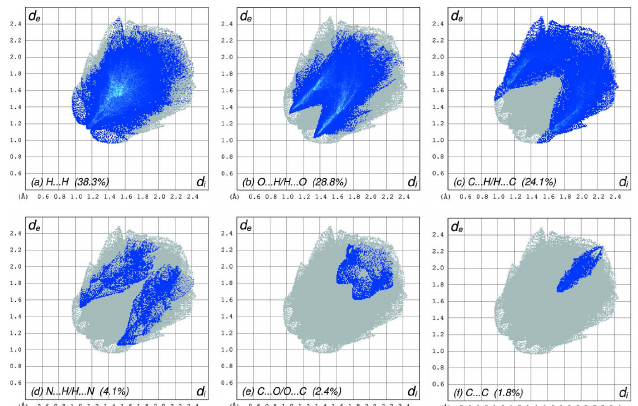
Figure 5 Hirshfeld surface analysis fingerprint plots showing the relative coverage of different atom-atom contacts in I : ( a ) H (cid:2)(cid:2)(cid:2) H = 38.3%, ( b ) O (cid:2)(cid:2)(cid:2) H/ H (cid:2)(cid:2)(cid:2) O = 28.8%, ( c ) C (cid:2)(cid:2)(cid:2) H/H (cid:2)(cid:2)(cid:2) C = 24.1%, ( d ) N (cid:2)(cid:2)(cid:2) H/H (cid:2)(cid:2)(cid:2) N = 4.1%, ( e ) C (cid:2)(cid:2)(cid:2) O/O. (cid:2) C = 2.4%, ( f ) C (cid:2)(cid:2)(cid:2) C = 1.8%. All other contacts are negligible.